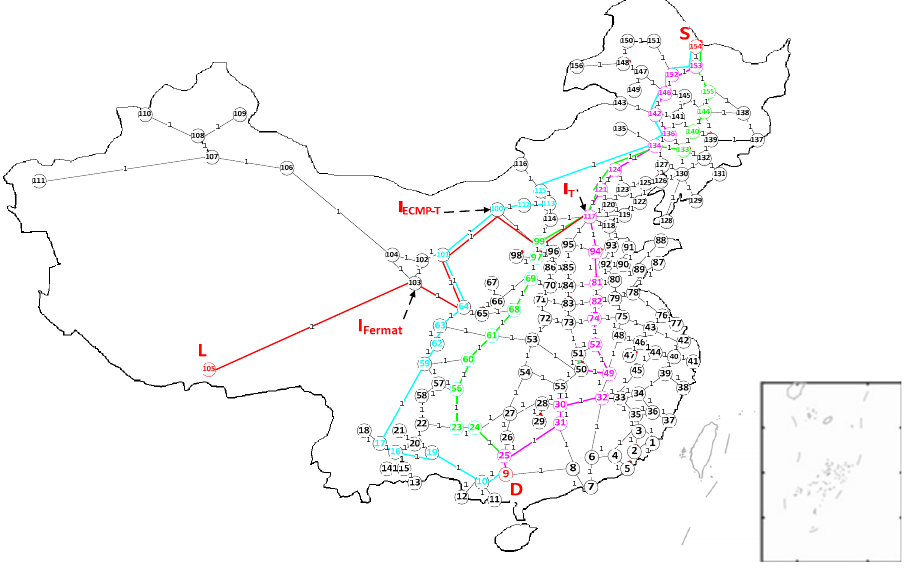
Figure 4. China’s 156 major railway nodes network (China Railway Network; CRN).